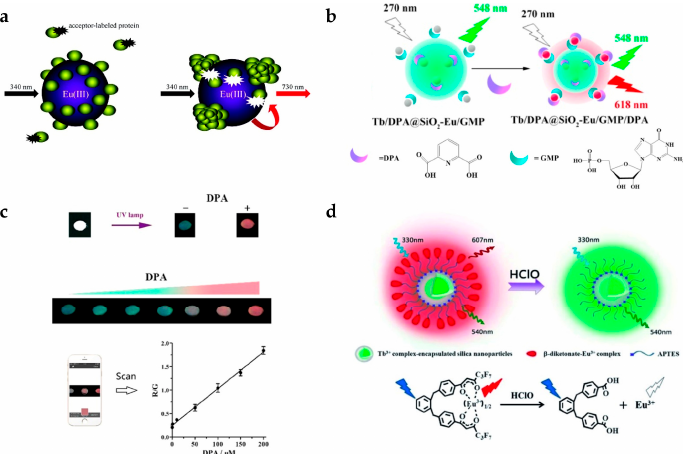
Figure 1. ( a ) Design concept of protein aggregation analysis using a luminescence resonance energy transfer (LRET) with Eu-doped polystyrene (PS) nanoparticles (NPs). Protein aggregation exposes the surface of PS NPs leading to the adsorption of dye-labeled protein. ( b – c ) The principle of dipicolinic acid (DPA) detection; ( b ) Surface binding of DPA induces the strong red emission of Eu/GMP by antenna effect; ( c ) Luminescence color images of DPA detection and ratiometric detection using dual-color channels; ( d ) Schematic illustration of hypochlorous acid (HClO) measurement. HClO induces ratiometric luminescence quenching by releasing Eu ions from Eu-complex. Reprinted with permission from [20,22,42].